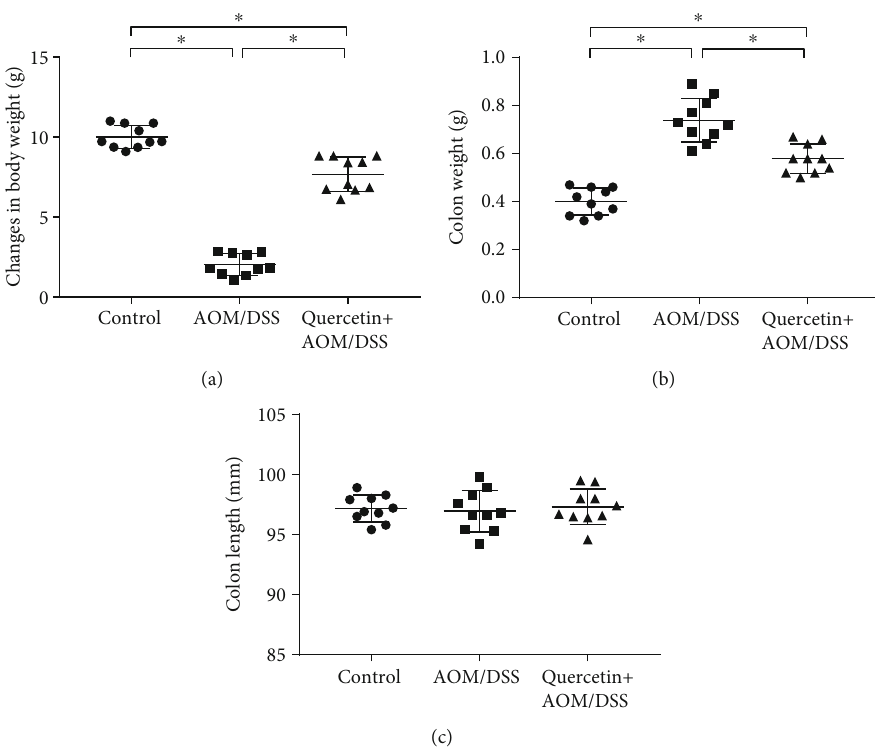
Figure 1: Quercetin restores body and colon weight in AOM/DSS-treated mice. (a) Quanti fi cation of body weight of control and experimental mice. (b) Quanti fi cation of colon weight of control and experimental mice. (c) Quanti fi cation of colon length of control and experimental mice. Data are expressed as mean values ± SD ( n = 10 /group). ∗ P < 0 : 05 , Student ’ s t